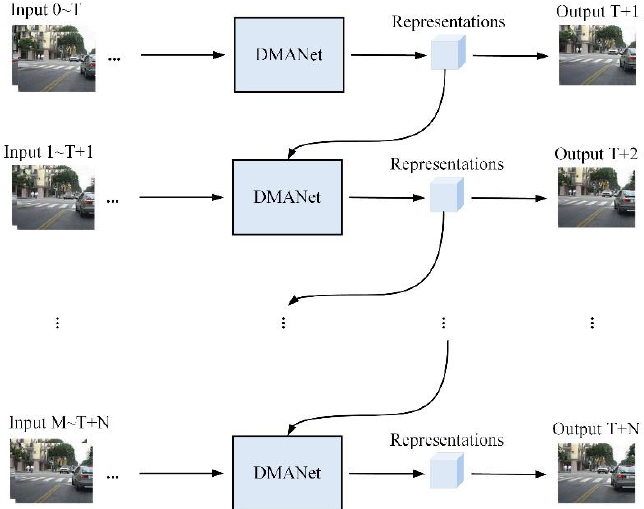
Figure 1. A flow chart of DMANet in long-term prediction.